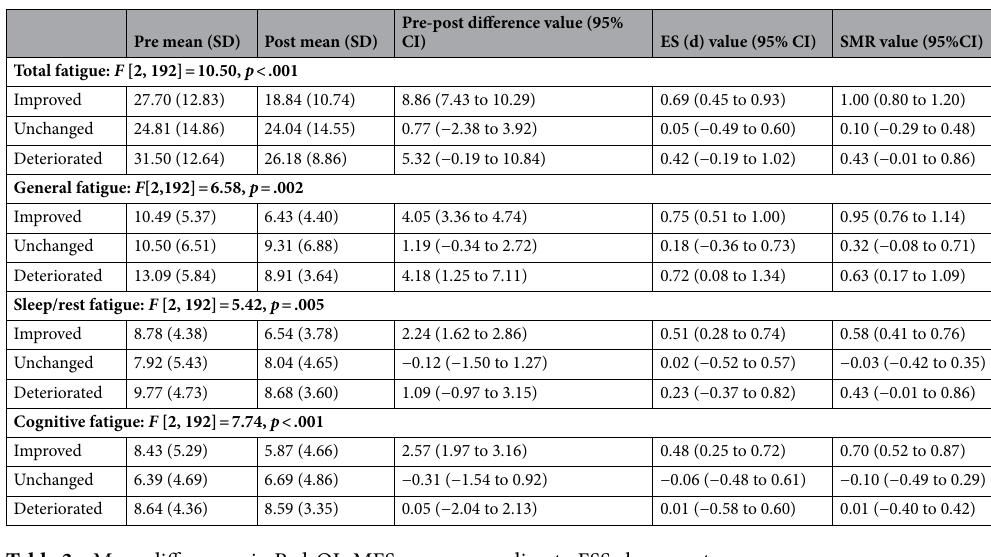
Pre-post difference value (95% Pre mean (SD) Post mean (SD) CI) ES ( d ) value (95% CI) SMR value (95%CI) Total fatigue: F (1, 193) = 26.59, p <